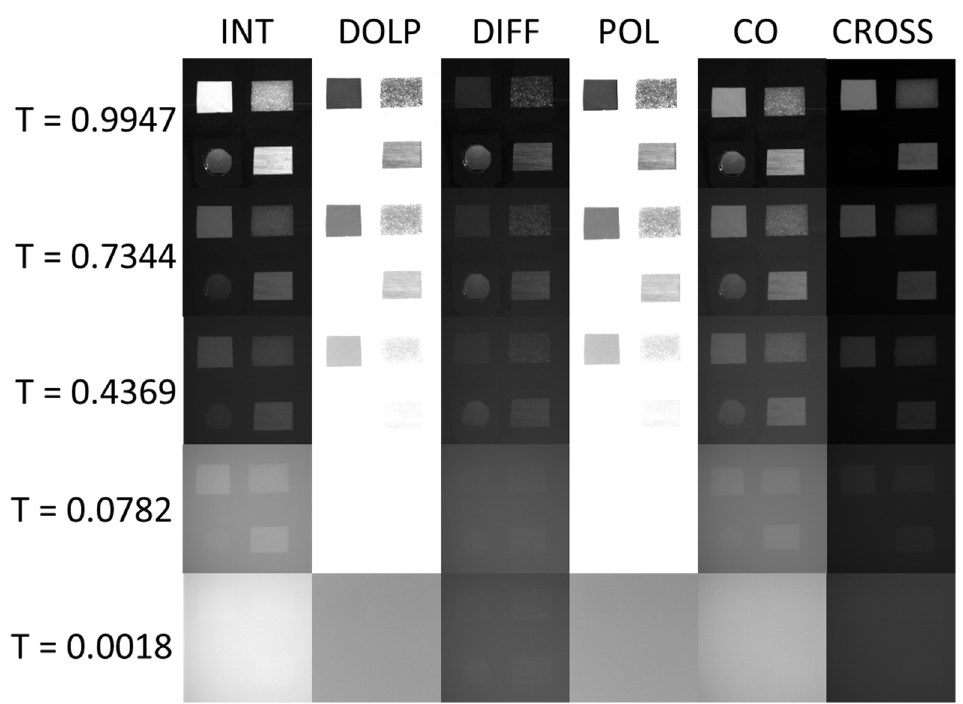
Figure 6. Images of the samples for the different image modes described in Table 4 under different fog transmittances, arranged in rows. T ~ 1 ( top ) corresponds to the absence of fog, while T ~ 0 ( bottom ) corresponds to the presence of very dense fog.